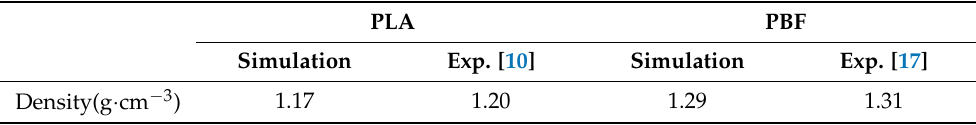
Table 1. Densities and solubility parameters of PLA and PBF from